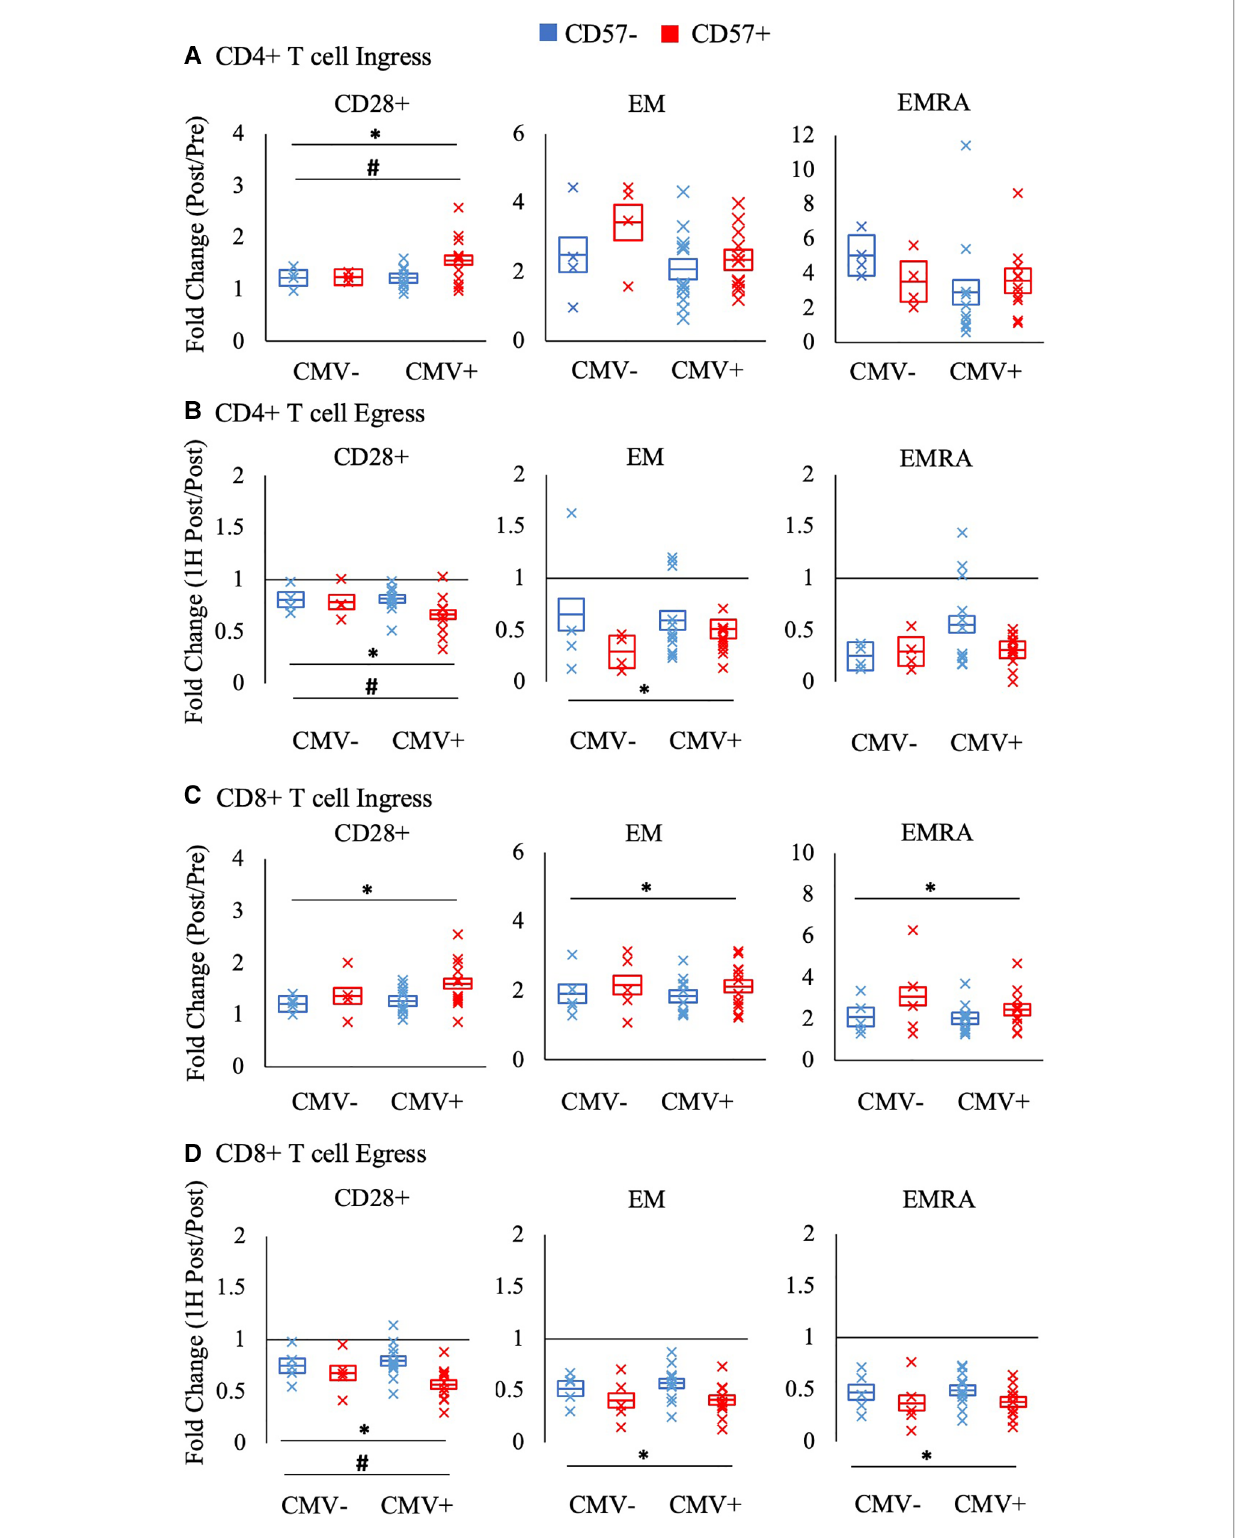
FIGURE 4 The relative mobilization of CD4+and CD8+ T-cell subsets by CD57 expression. Ingress (panels A and C) re fl ects the fold change in the concentration of cells post-exercise relative to pre-exercise, and egress (panels B and D) re fl ects the fold change 1H post-exercise relative to post-exercise. The fold change in CD57+and CD57- subsets of CD28+, EM, and EMRA CD4+and CD8+ T-cells amongst CMV seronegative and seropositive participants is shown. Data are displayed as estimated marginal means (line) and standard error (box). Individual data points from each participant are also indicated (x). Signi fi cant main effect of CD57 expression indicated by *. Signi fi cant interaction effect between CD57 expression and CMV indicated by #. EM: effector memory, EMRA: RA+effector memory, CMV: